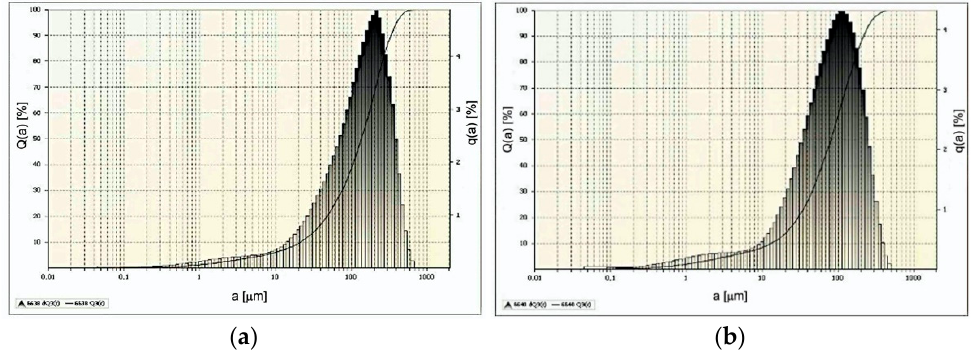
Figure 11. Example distributions of polymetallic nodule particles comminuted in a hydro-jet mill (for d w = 0.7 mm, d h = 2.4 mm, s = 10 mm) at water jet pressures: ( a ) 70 MPa, ( b ) 100 MPa.